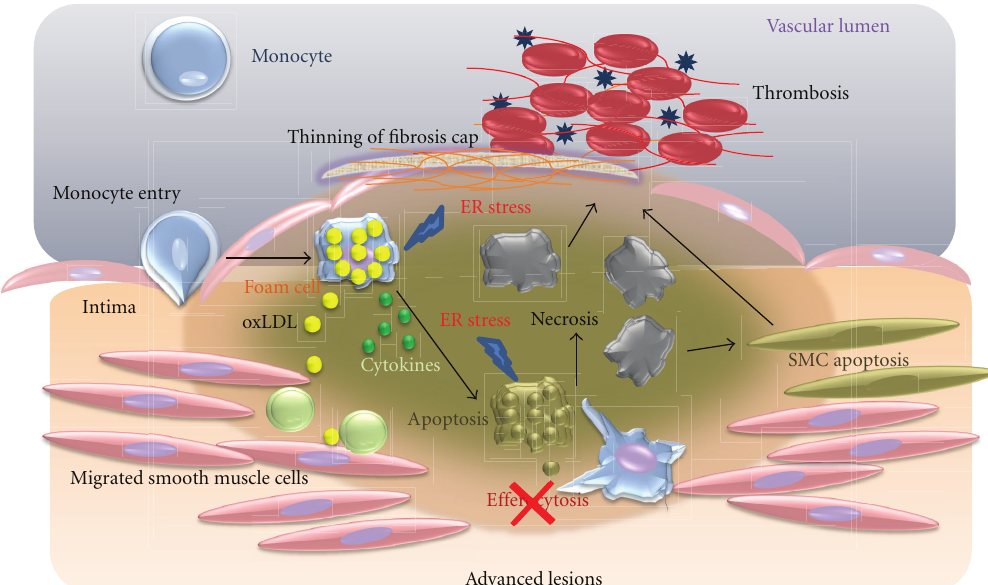
Figure 4: Cellular interactions with macrophages in an advanced lesion. Foam cells accumulate in the intima and undergo apoptosis that is triggered by cytokines. E ff erocytes do not function properly, and apoptotic cells secondarily become necrotic cells, contributing to the formation of a necrotic core. Necrosis of macrophages and SMCs decrease collagen synthesis to diminish the collagen content of the fibrous cap, triggering rupture and